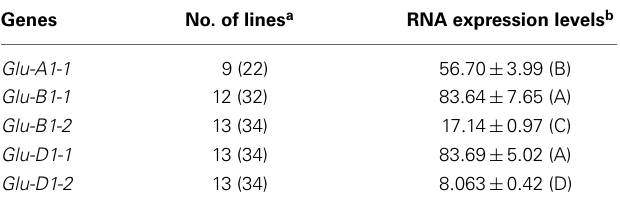
Table 4 | Comparison of the transcription levels of HMW-GS genes at 400 ◦ C days after anthesis for 13 lines of INRA worldwide hexaploid wheat core collection.